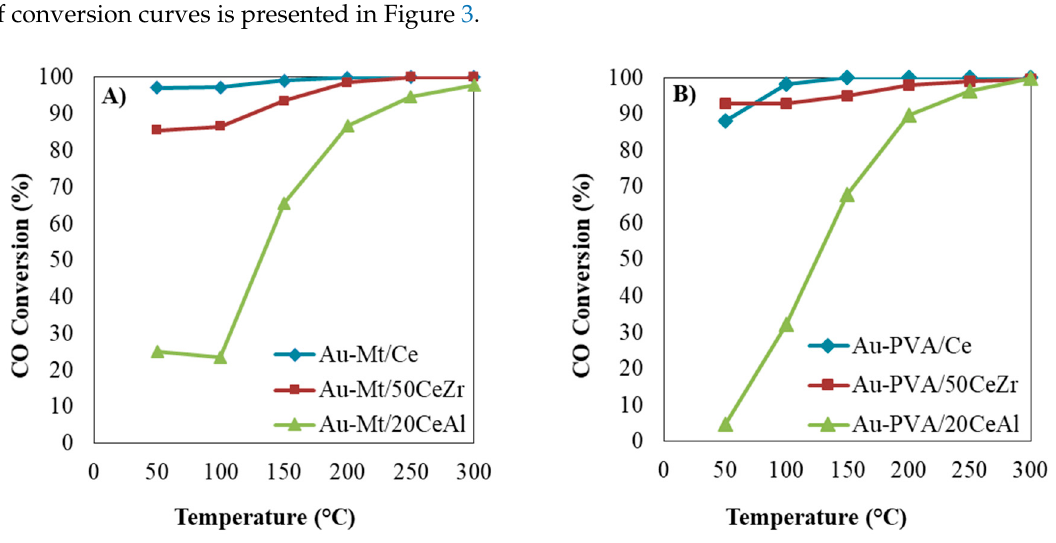
Figure 2. TEM micrographs and particle size distributions of ( A ) Mt- and ( B ) PVA-solids.